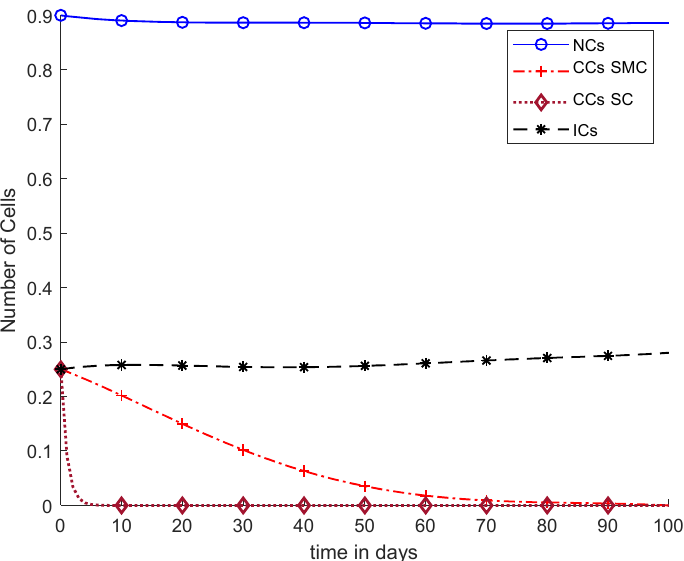
Figure 11. With chemotherapy at a constant dose, SMC on CCs (‘+’ line) with effect on all equations, and SC on CCs (‘ − ’ line).